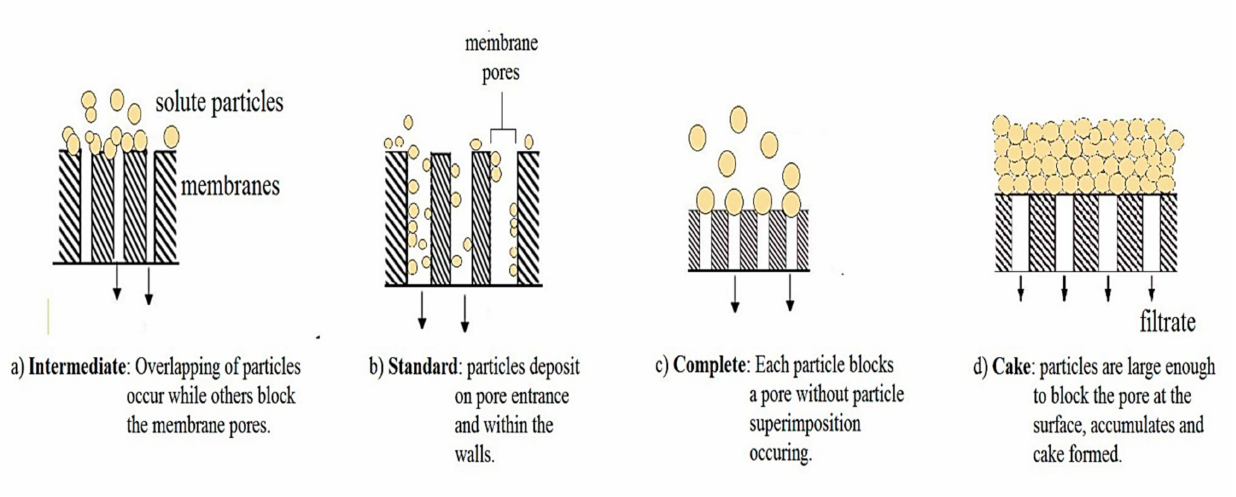
Figure 6. Schematic view of the different pore blocking